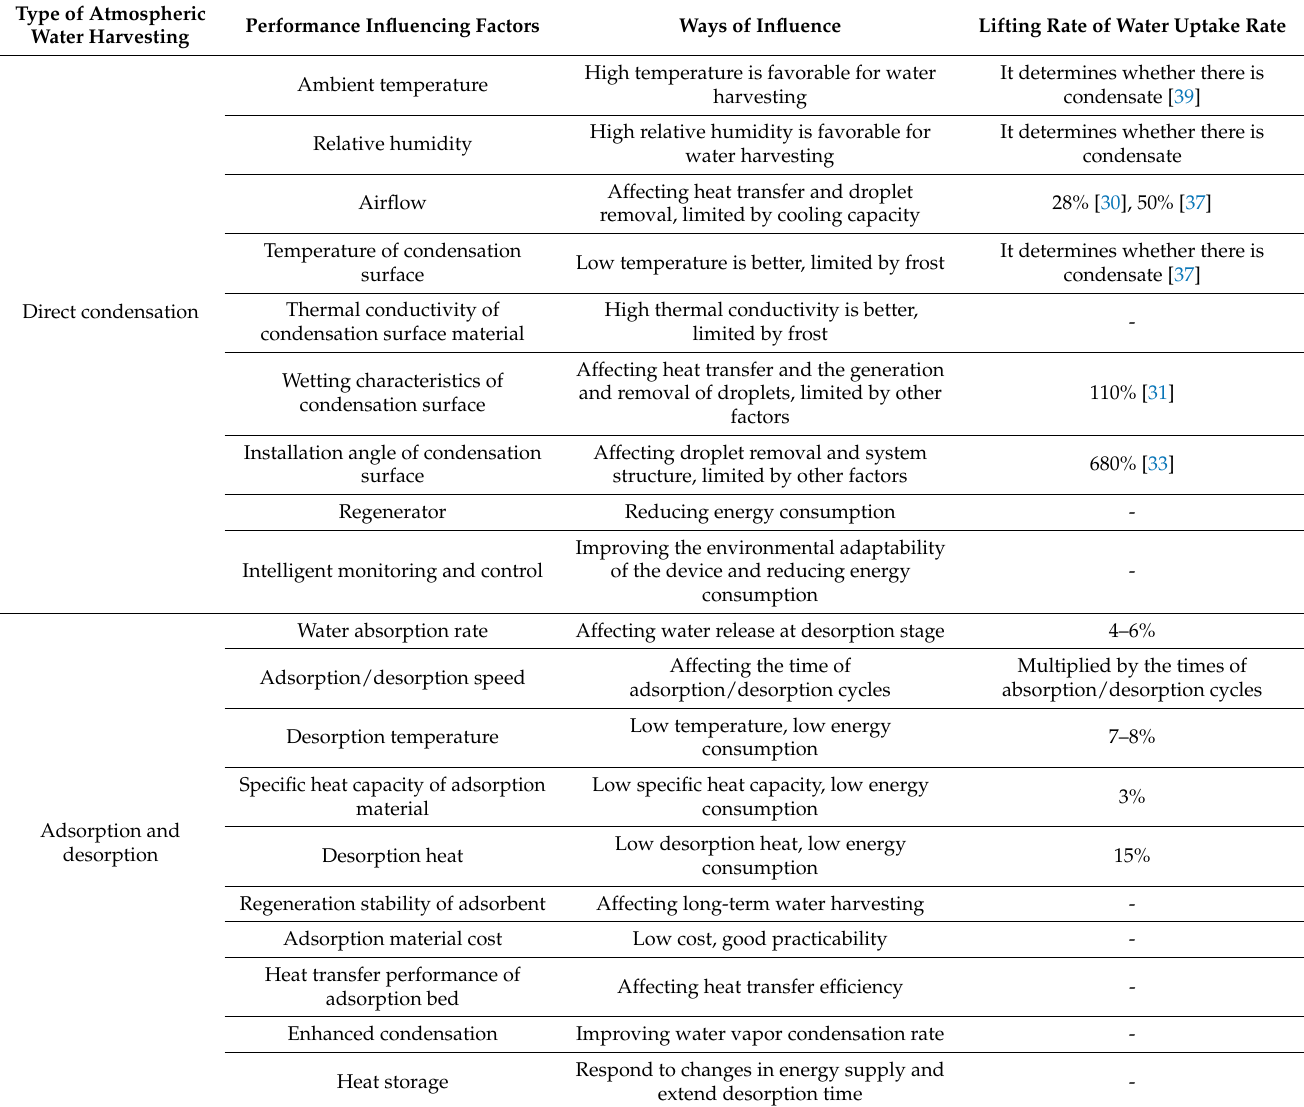
Table 4. Performance influencing factors and influencing results of various atmospheric vapor harvesting